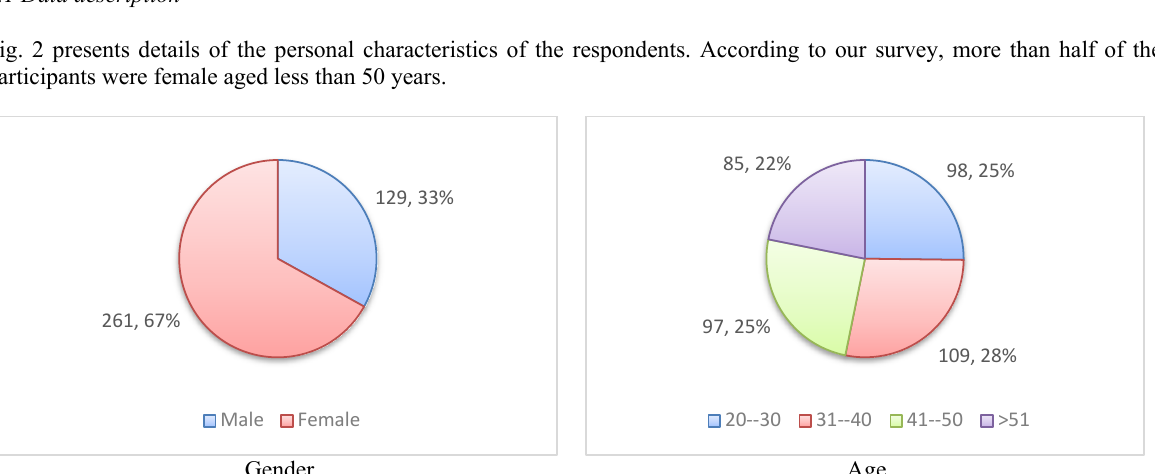
Fig. 2. Personal characteristics of the participants